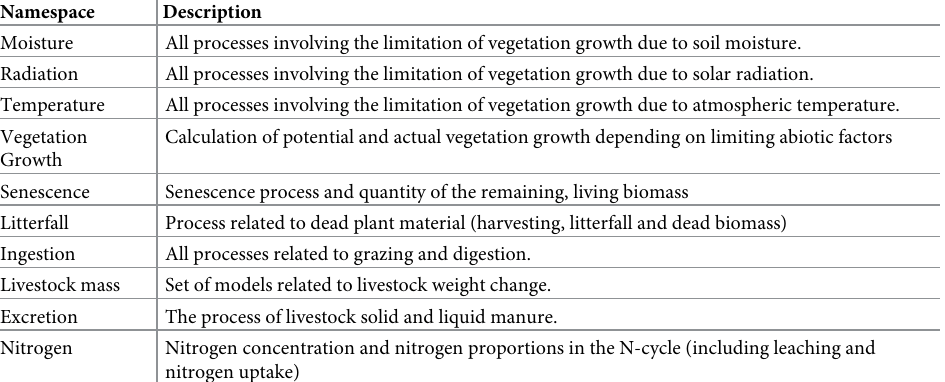
Table 2. Description of PaL namespaces related to climatic growth limitations, vegetation life cycle, livestock grazing and nitrogen